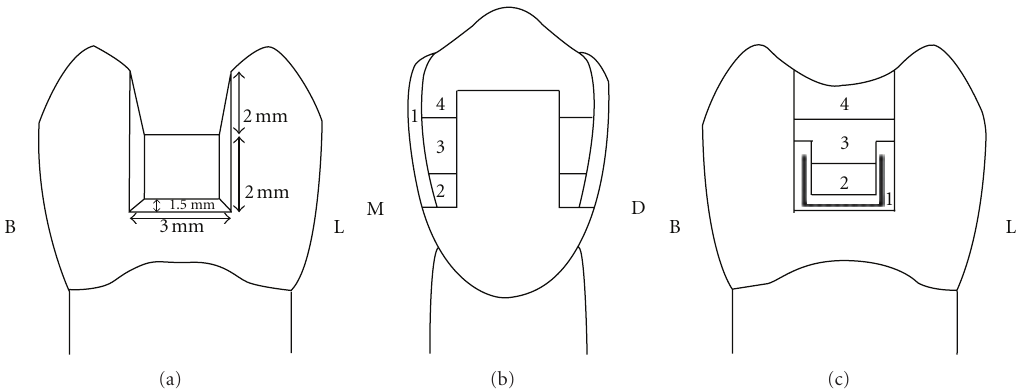
Figure 1: Various placement techniques in experimental groups from buccolingual (BL) or mesiodistaln (MD) view: bulk (a), centripetal (b), and fiber insert (c).